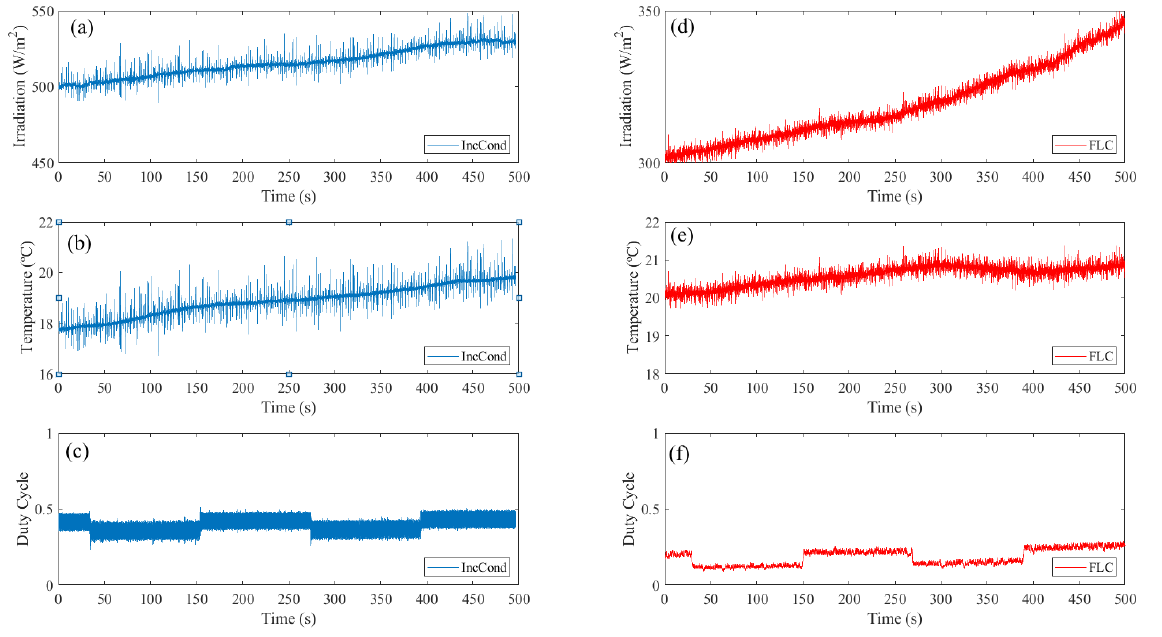
Figure 7. Weather conditions and duty cycle signals generated by IncCond and FLC tracking algorithms: ( a ) irradiation (W/m 2 ) used for the experiment of the IncCond; ( b ) temperature ( ◦ C) used for the experiment of the IncCond; ( c ) duty cycle signal generated by IncCond; ( d ) irradiation (W/m 2 ) used for the experiment of the FLC; ( e ) temperature ( ◦ C) used for the experiment of the FLC; and ( f ) duty cycle signal generated by